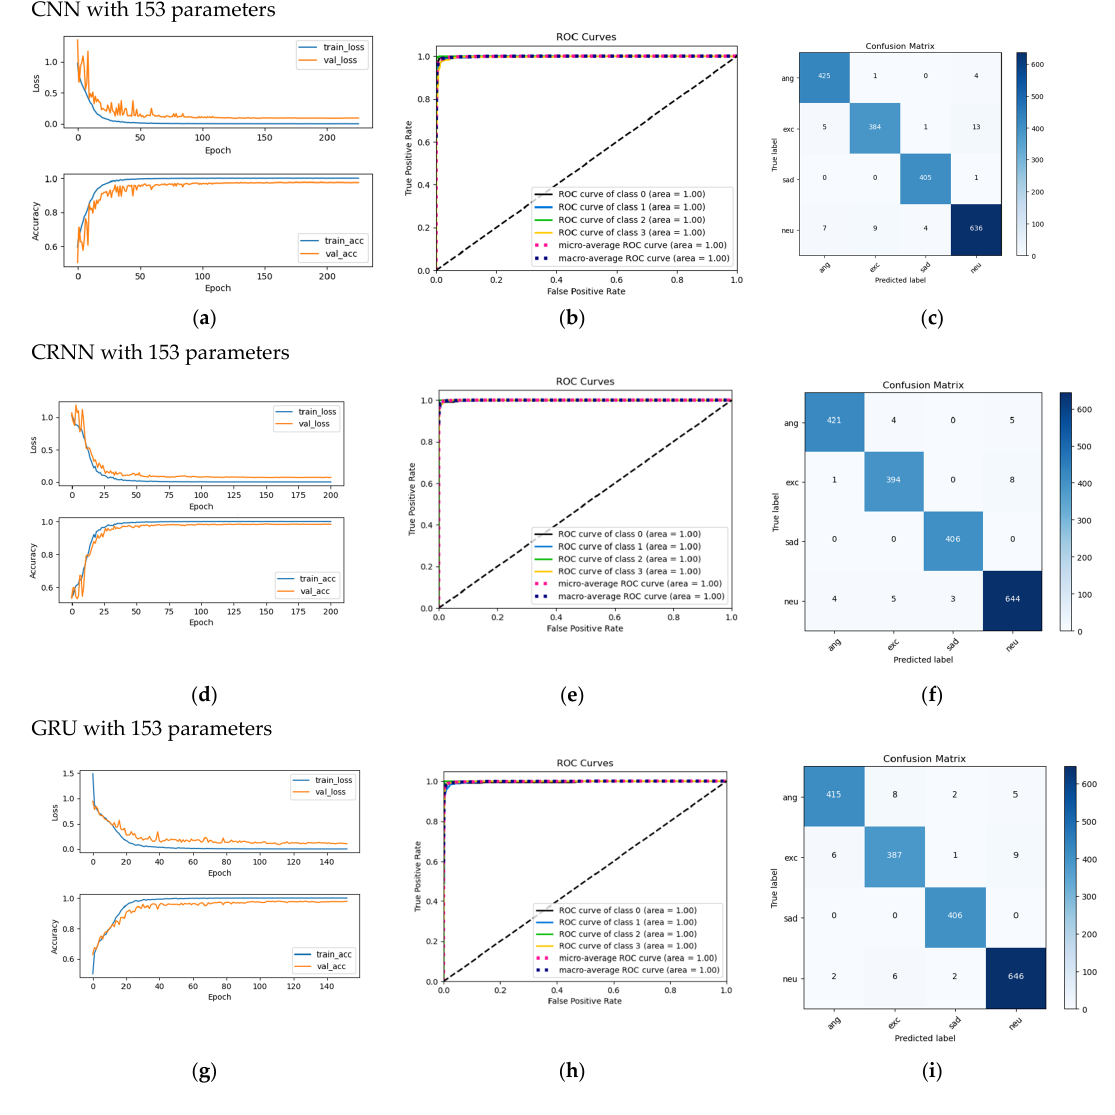
Figure 7. ( a , d , g ) Examples of loss and accuracy variations according to the epoch for training and validation for a fold; ( b , e , h ) ROC (class 0: anger, class 1: exc, class 2: sad, class 3: neu.); and ( c , f , i ) confusion matrix. Table 13. Accuracy, AUC and precision, recall, f1-score for each emotion for GRU model using 153 parameters without data